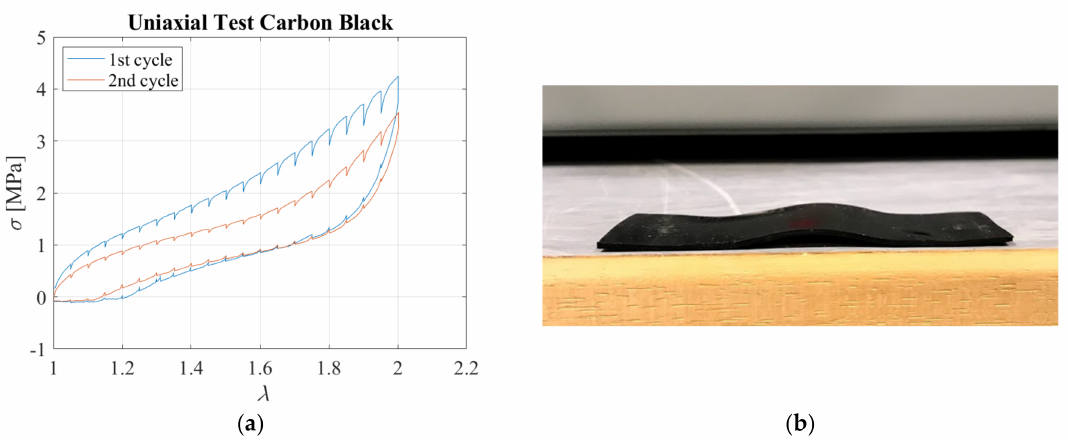
Figure 6. ( a ) Tensile stress − extension curves for two cycles; ( b ) Sample immediately after tensile test.